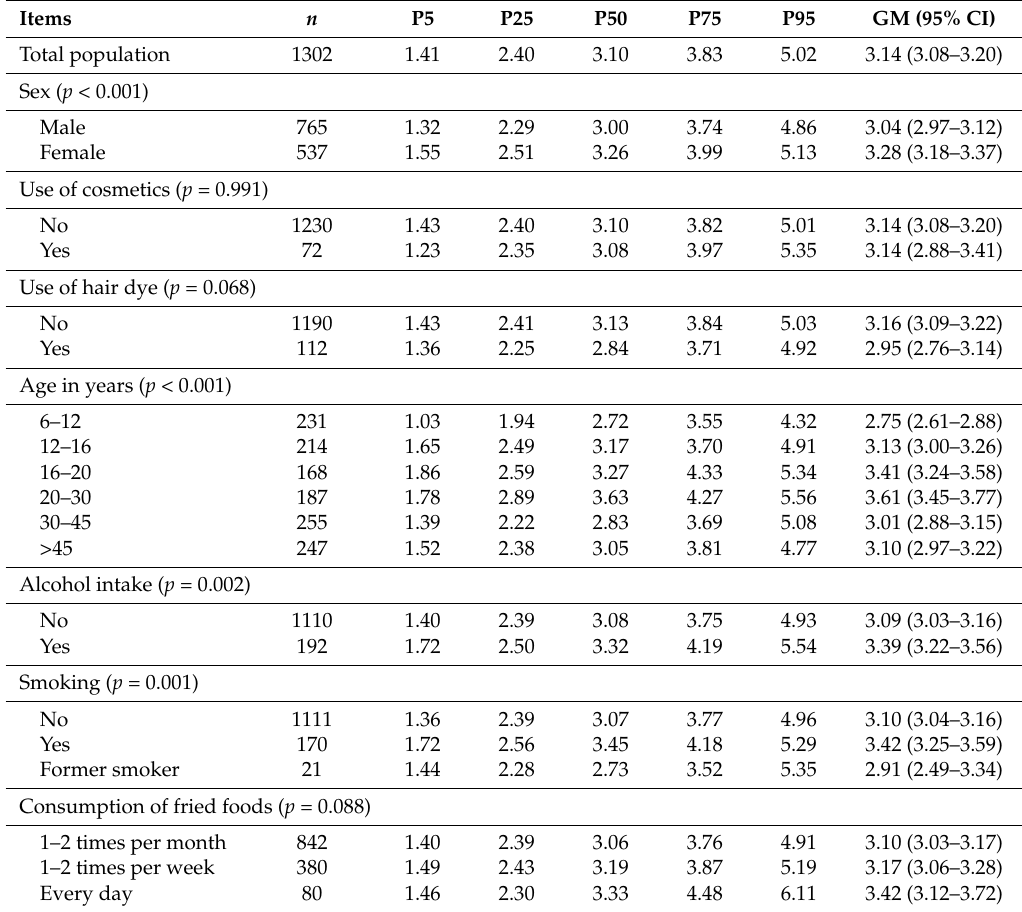
Table 1. Blood 66 Zn levels (mg/L), stratified by relevant categorical variables.